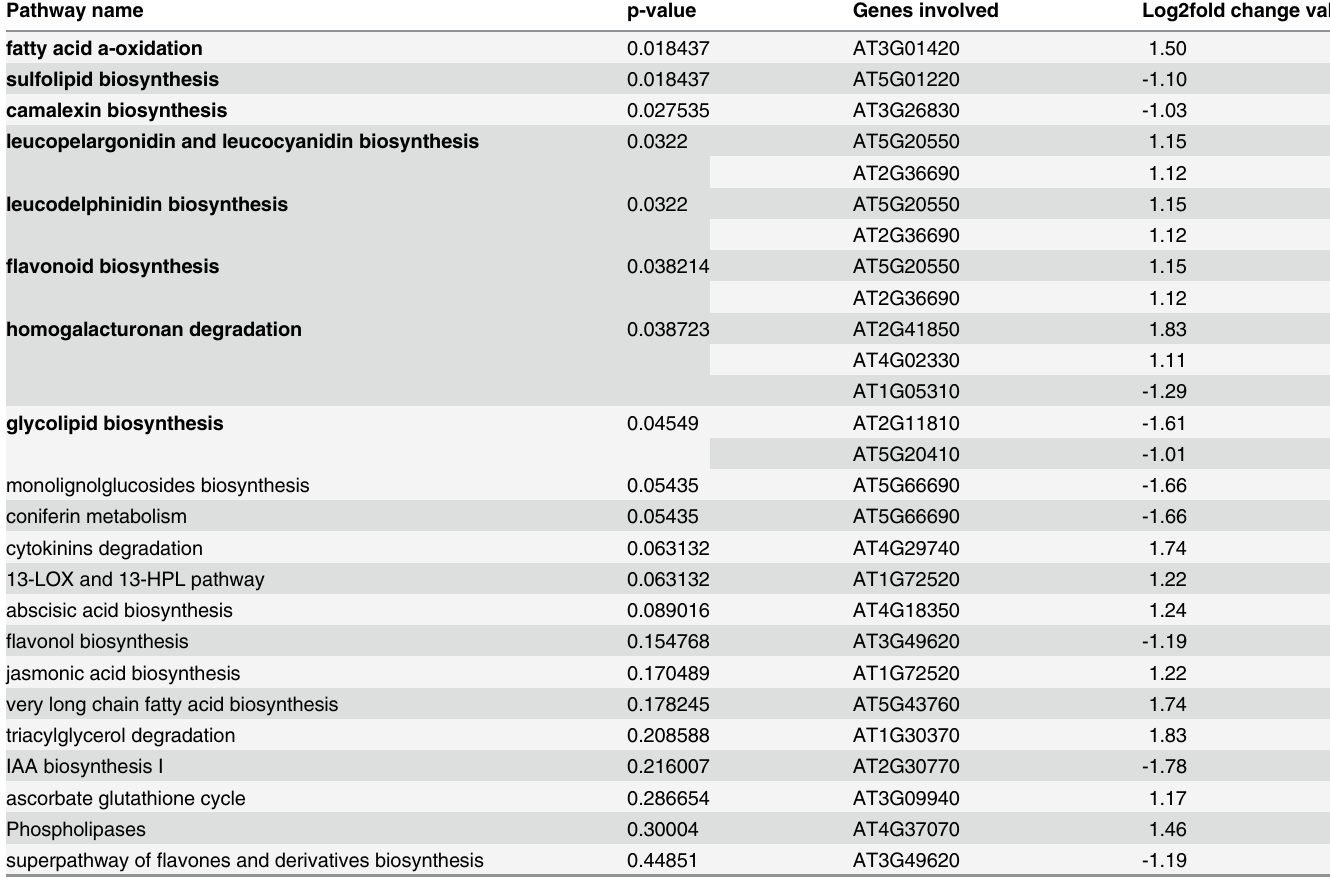
Table 2. List of changed pathways with the genes and their log2fold change value involved in the